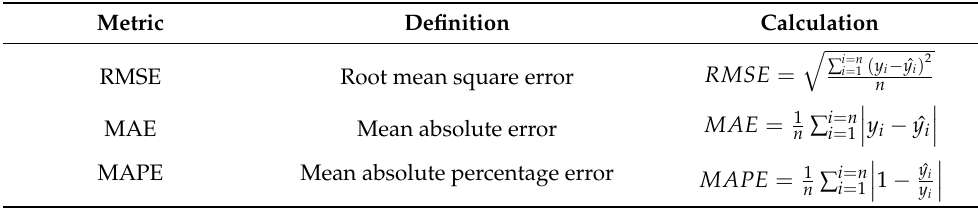
Table 1. Evaluation